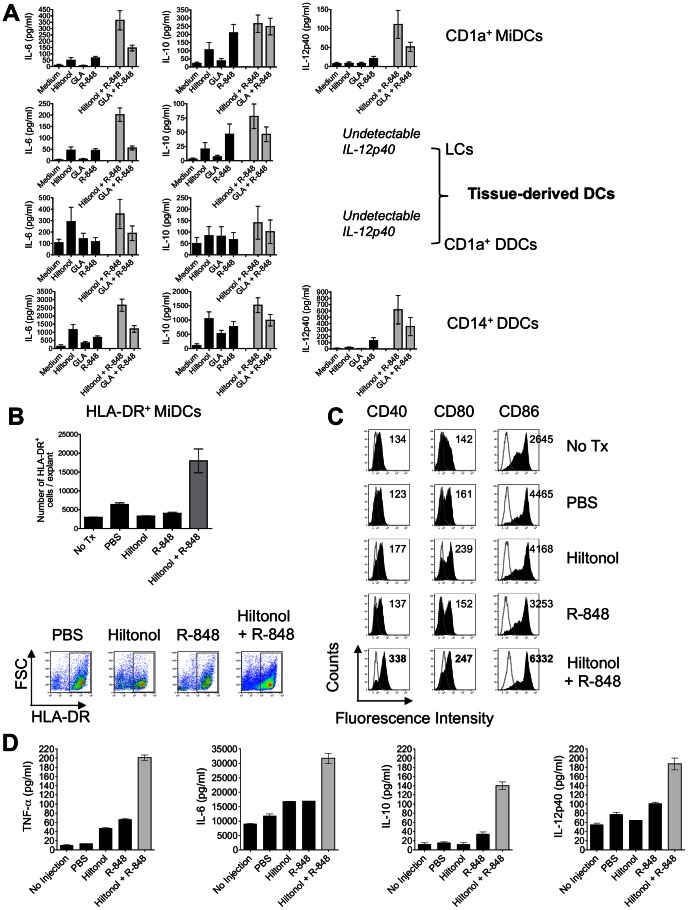
The Hiltonol plus R-848 combination potently activates multiple skin DC subsets.(A) The Hiltonol plus R-848 combination enhances cytokine secretion from multiple DC subsets after stimulation with selected TLR ligand(s). CD1a+ MiDCs (n = 5 donors), tissue-derived LCs (n = 4 donors) and CD1a+ DDCs (n = 3 donors) were stimulated with TLR ligand(s) for 48 h (∼2×104/condition) before cytokine concentrations were quantified by ELISA. For comparison, data derived using CD14+ DDCs are also displayed (n = 7 donors). The data are presented as means ± SEM. (B) Enhanced migration of MiDCs after microinjection with Hiltonol plus R-848. MiDCs were quantified by flow cytometry after gating on FSChi SSChi HLA-DR+ cells. (C) Phenotypic analysis of MiDCs following microinjection of skin explants with TLR ligand(s). Skin explants were injected with PBS, Hiltonol, R-848, or Hiltonol plus R-848. Explants were cultured for 48 h and compared to explants receiving no treatment (no Tx). Migratory DCs were identified as large (FSChi SSChi), HLA-DR+ cells and analyzed for CD40, CD80 and CD86 expression. Mean fluorescence intensity (MFI; geometric mean) are displayed on histograms. Gray open histograms represent isotype controls. (D) Cytokine expression in supernatants from skin explants following microinjection with TLR ligand(s). Cell-free supernatants were collected 48 h after injection and their IL-6, IL-10, TNF-α and IL-12p40 content was quantified by ELISA.